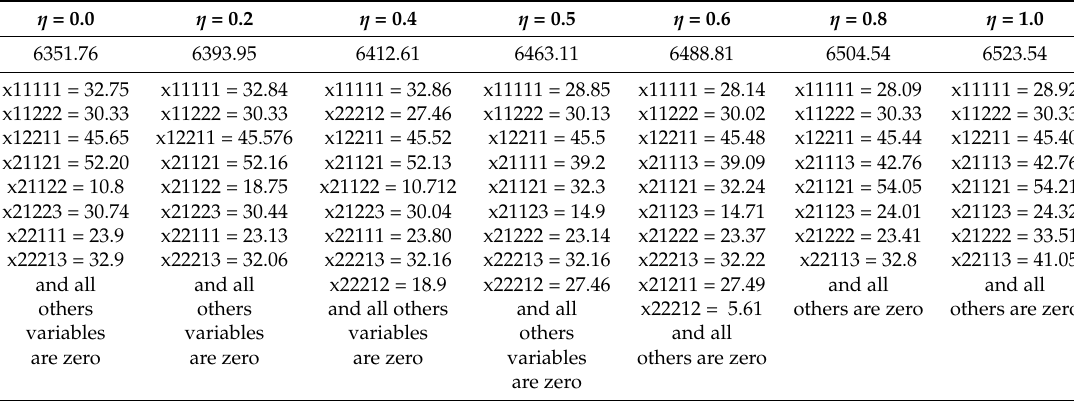
Table 7. Optimum results for Model-II (Expected Value Technique) by Lingo.